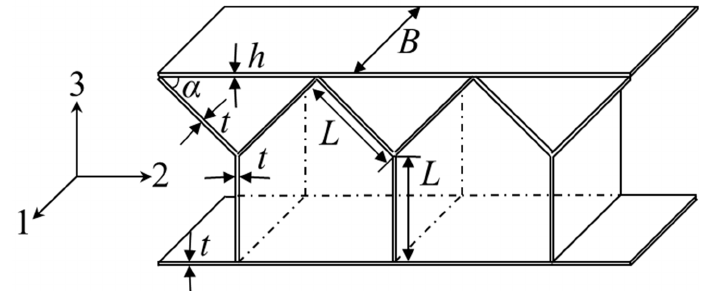
Figure 1. Schematic of with Y-shape cored sandwich panel.